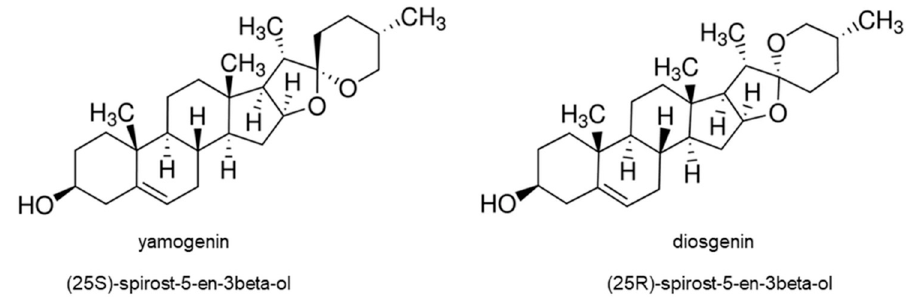
Figure 1. The structure of yamogenin and diosgenin.